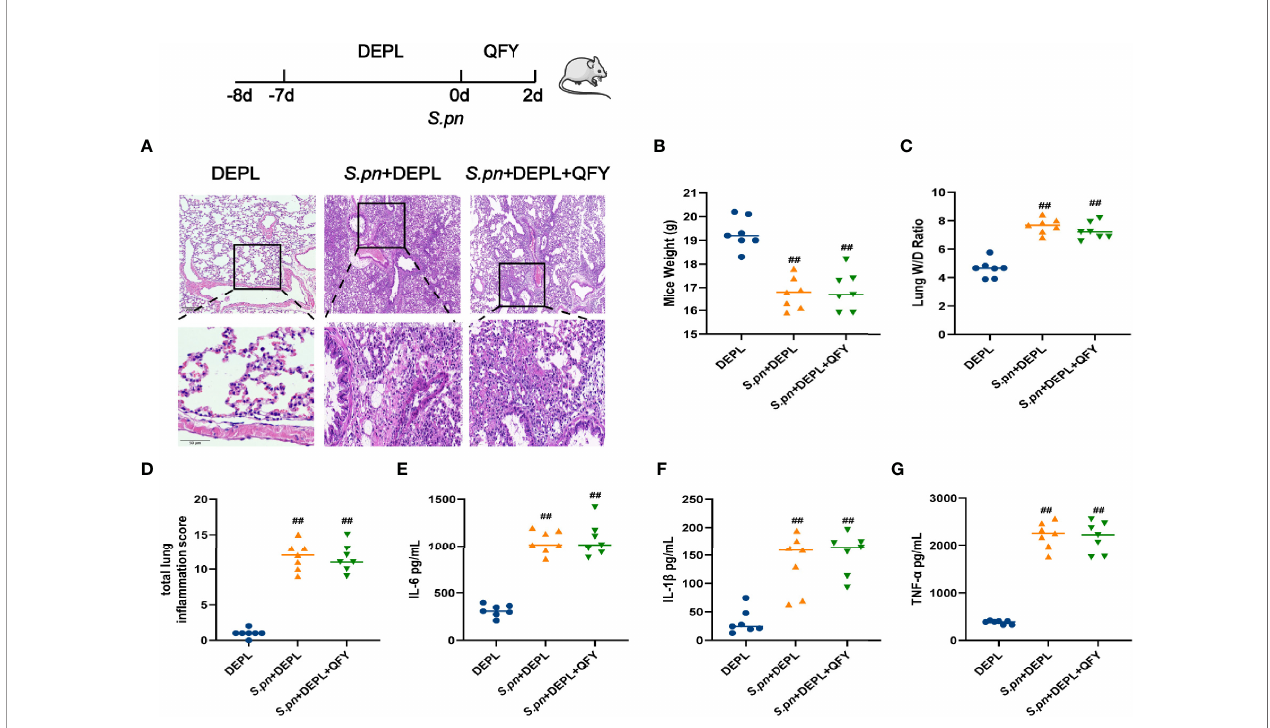
FIGURE 5 | Mice assigned to DEPL, S.pn +DEPL, and S.pn +DEPL +QFY groups were fi rst administered broad-spectrum antibiotics in drinking water then were intranasally inoculated with 2.5 × 10 8 CFU/mL S.pn in a volume of 25 m L and monitored for 48 h. (A) Pathologic and histopathological changes in lung tissues as revealed by H&E staining (original magni fi cation 40×, scale bar: 20 m m). (B) Total lung in fl ammation score. (C) Body weight and (D) lung W/D ratio of mice. (E – G) Levels of in fl ammatory cytokines IL-1 b , IL-6, and TNF- a . Data are presented as the mean ± SD for each group, ## p < 0.01 versus